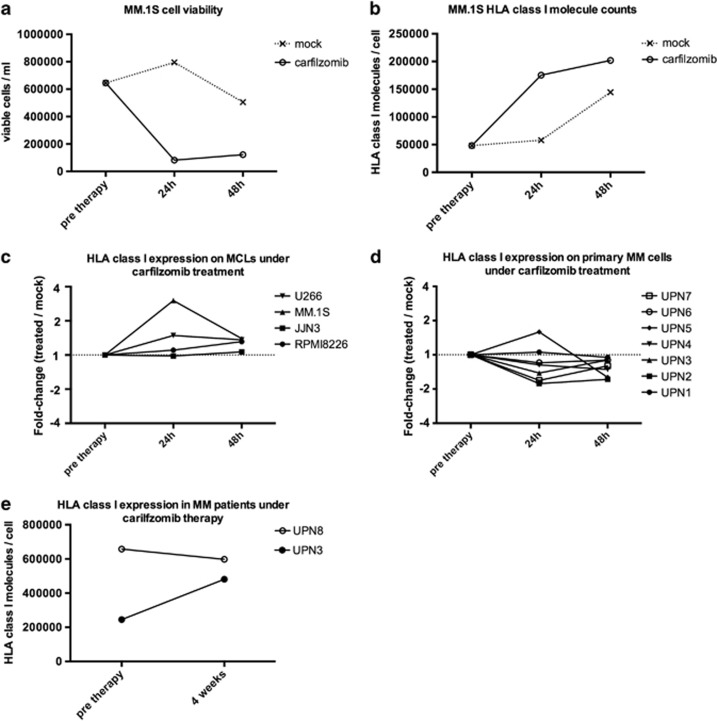
Effects of carfilzomib on myeloma cell viability and HLA class I surface expression. Quantification of HLA surface expression was performed using a bead-based flow-cytometric assay using the pan-HLA class I-specific monoclonal antibody W6/32. (a) Viability of MM.1S cells before in vitro treatment and 24 h/48 h after a 1-h pulse with 100 nm carfilzomib (Carfilzomib) or 5% glucose (MOCK). Cell viability was determined using the trypan blue exclusion test. (b) Absolute counts of HLA class I surface molecules on MM.1S cells under in vitro treatment. (c) Longitudinal analysis of relative, mock-normalized changes in HLA class I surface expression on four different MCLs under in vitro treatment. (d) Longitudinal analysis of relative, mock-normalized changes in HLA class I surface expression on primary CD38+CD138+ myeloma cells from seven different patients (UPN1-7) under in vitro treatment. (e) Absolute counts of HLA class I surface molecules on primary CD38+CD138+ myeloma cells from bone marrow aspirate of two different patients before commencement of therapy and after 4 weeks of treatment with carfilzomib.